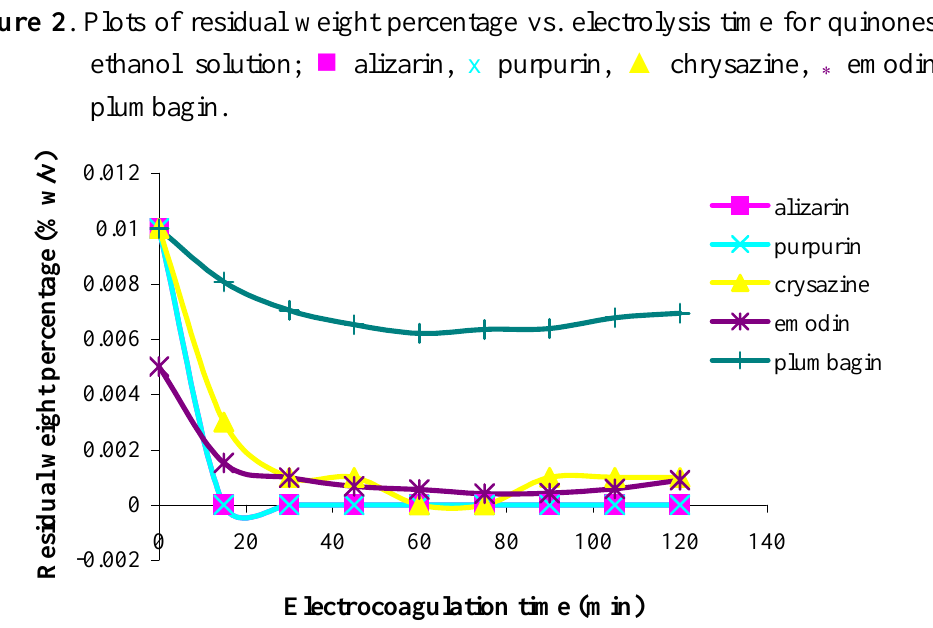
Figure 2 . Plots of residual weight percentage vs. electrolysis time for quinones in 85% ethanol solution; (cid:132) alizarin, x purpurin, ▲ chrysazine,